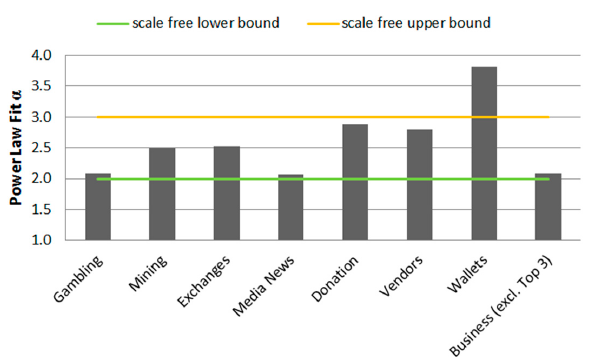
Figure 24. Power Law Fit α for Business Categories.